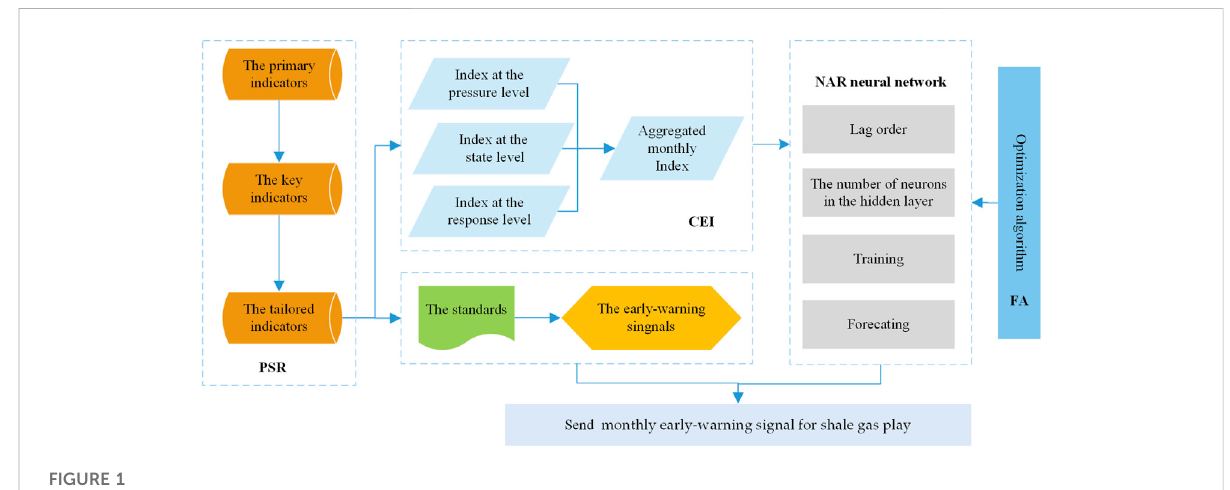
FIGURE 1 Flowchart of the PSR-FA-NAR